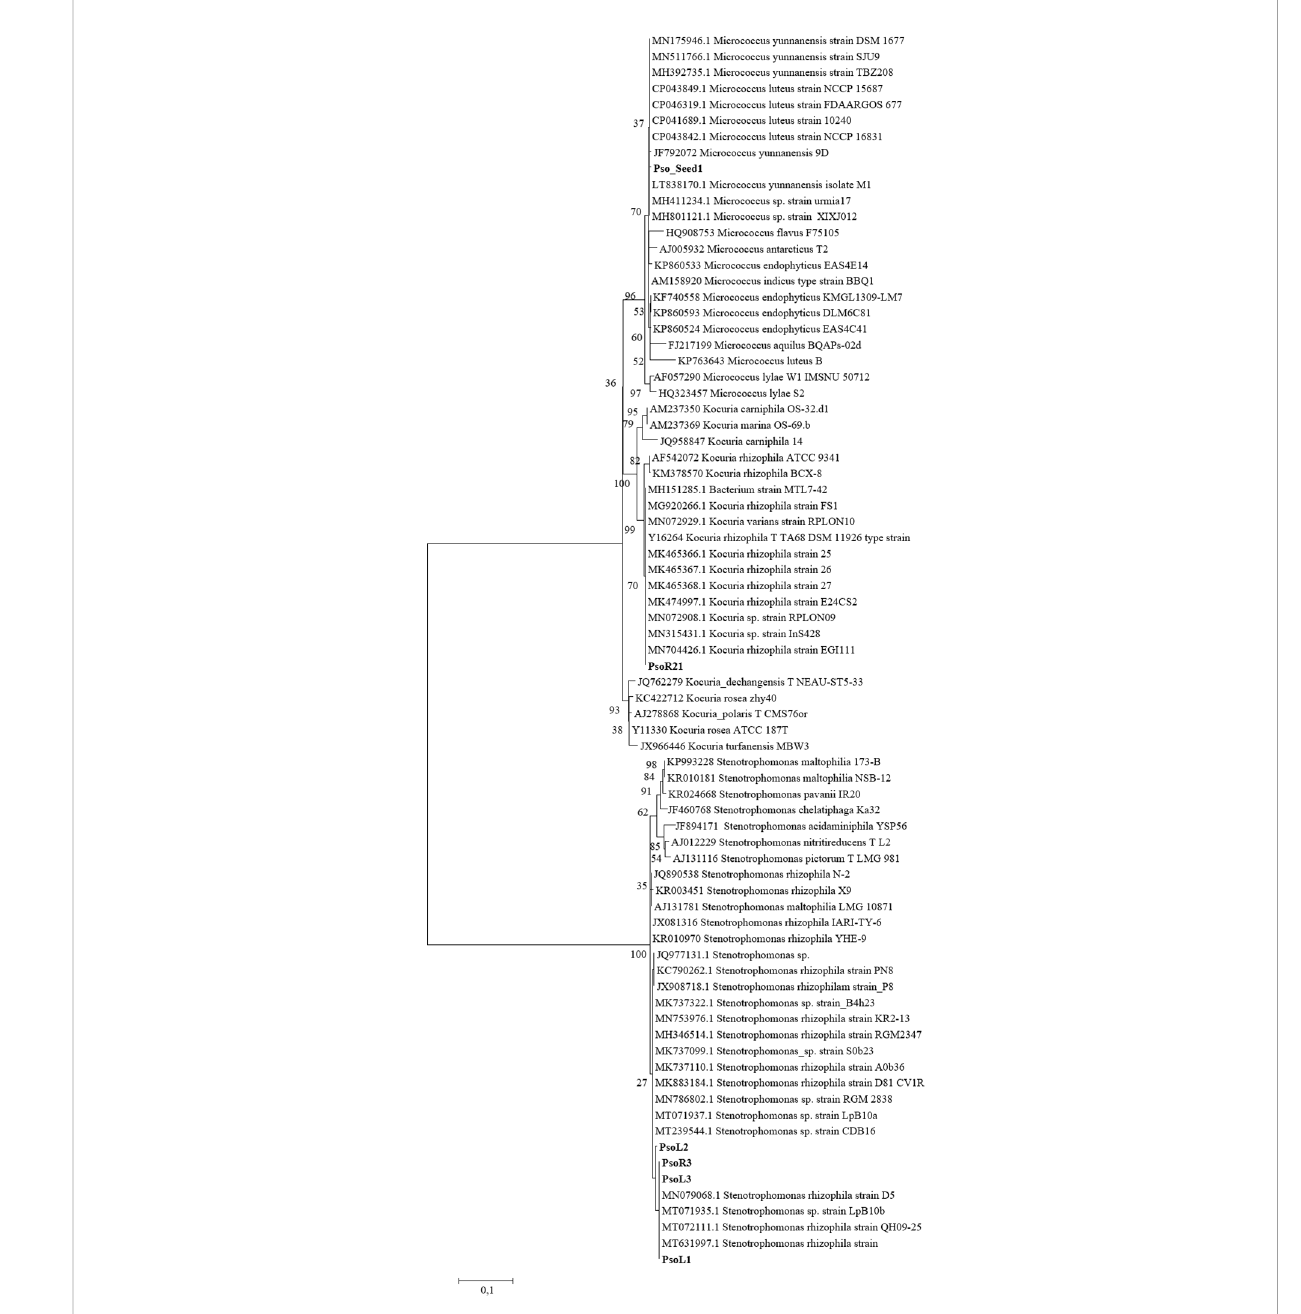
FIGURE 1 Phylogenetic tree reconstruction based on the 16S rRNA gene, obtained with maximum likelihood method on a total of 77 sequences, 6 of them belonging to our strains (highlighted in bold) and 71 high quality sequences selected among those most similar to our isolated